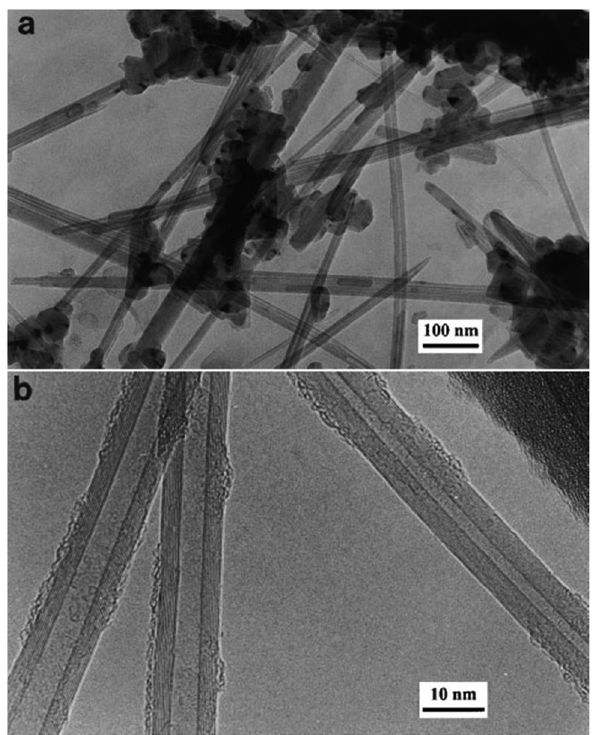
Figure 2: ( a ) The TEM image of nanotubes mixed with some disor - dered carbon and ( b ) the higher magni fi cation image of individual MWCNTs [ 2 ] .